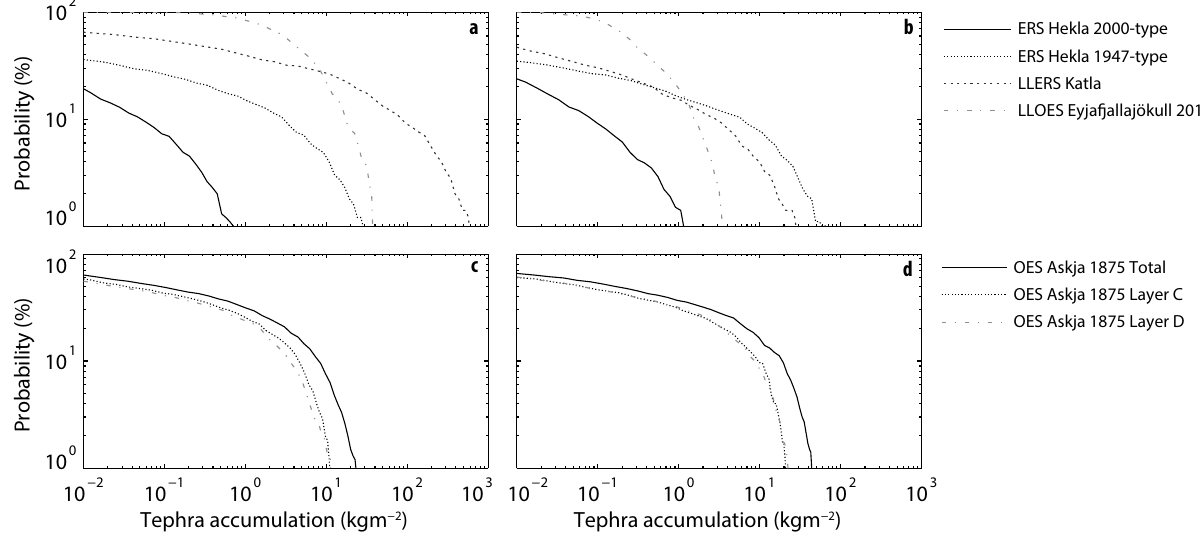
Figure 12. Hazard curves for the locations of (a) Vík, (b) Gullfoss, (c) Akureyri and (d) Egilsstaðir (see locations in Fig. 1). Only relevant eruptions are shown at each location, i.e. ERS Hekla 2000- and 1947-type, LLERS of Katla and LLOES 2010-type of Eyjafjallajökull for Vík and Gullfoss and OES 1875-type of Askja (total eruption and individual phases) for Akureyri and